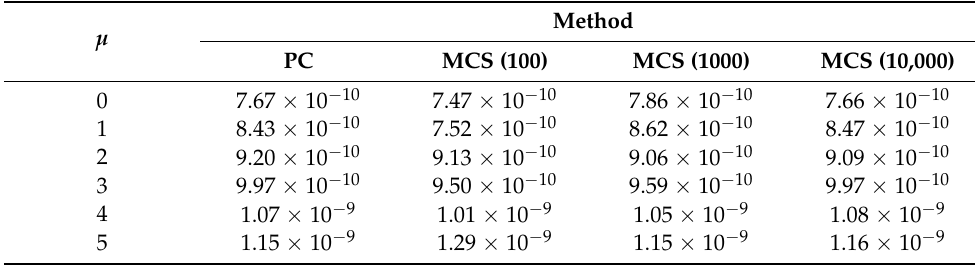
Table 6. The standard variance calculated by PC and